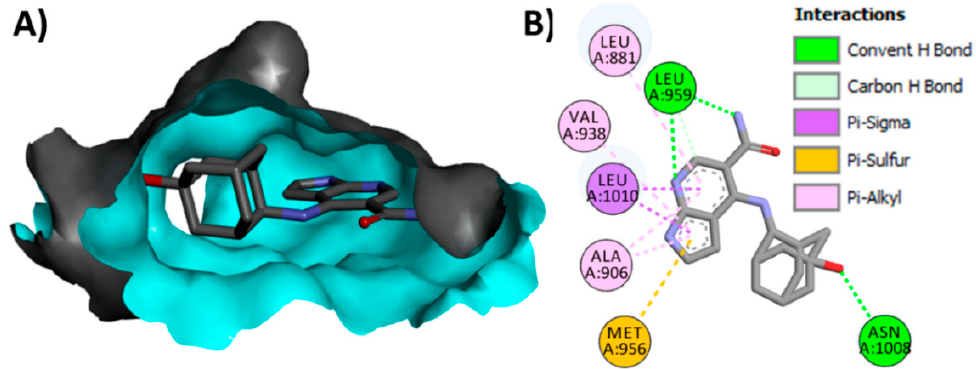
Figure 45. Binding modes of peficitinib (shown as sticks) into JAK1 (pdb: 6AAH): ( A ) 3D binding mode, receptor shown as a hydrogen bond surface; ( B ) 2D binding mode showing different types of interactions with JAK1; the figure was generated using Discovery Studio Visualizer (V16.1.0.15350). The binding interactions of peficitinib in JAK2 (pdb: 6AAJ) show two conventional hydrogen bonds with Glu930 and Leu932, Figure 46. In addition, peficitinib forms one carbon hydrogen bond with Glu930.